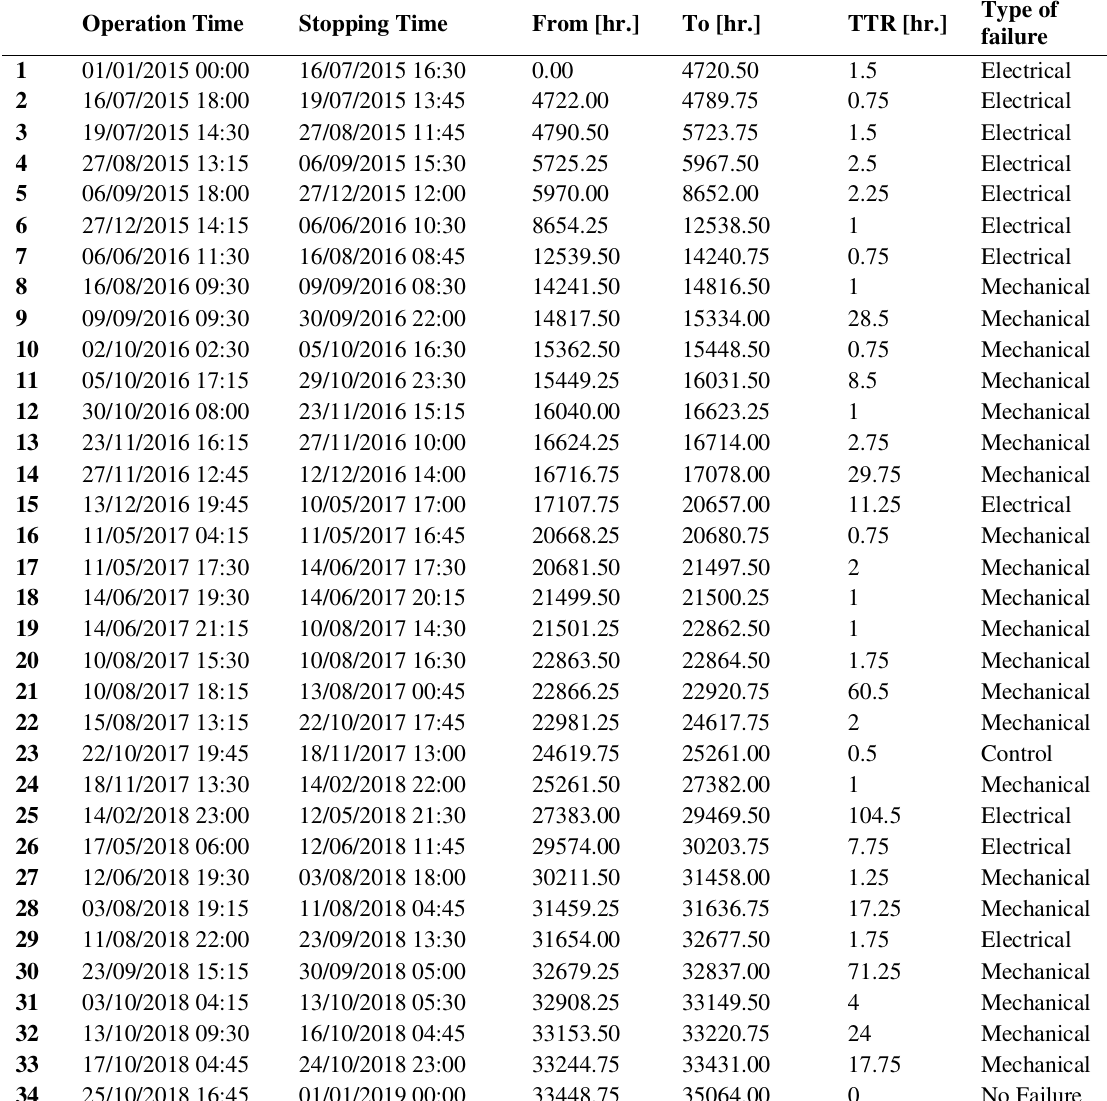
Table 1, Data collected of the generator and type of failure. Operation Time Stopping Time From [hr.]